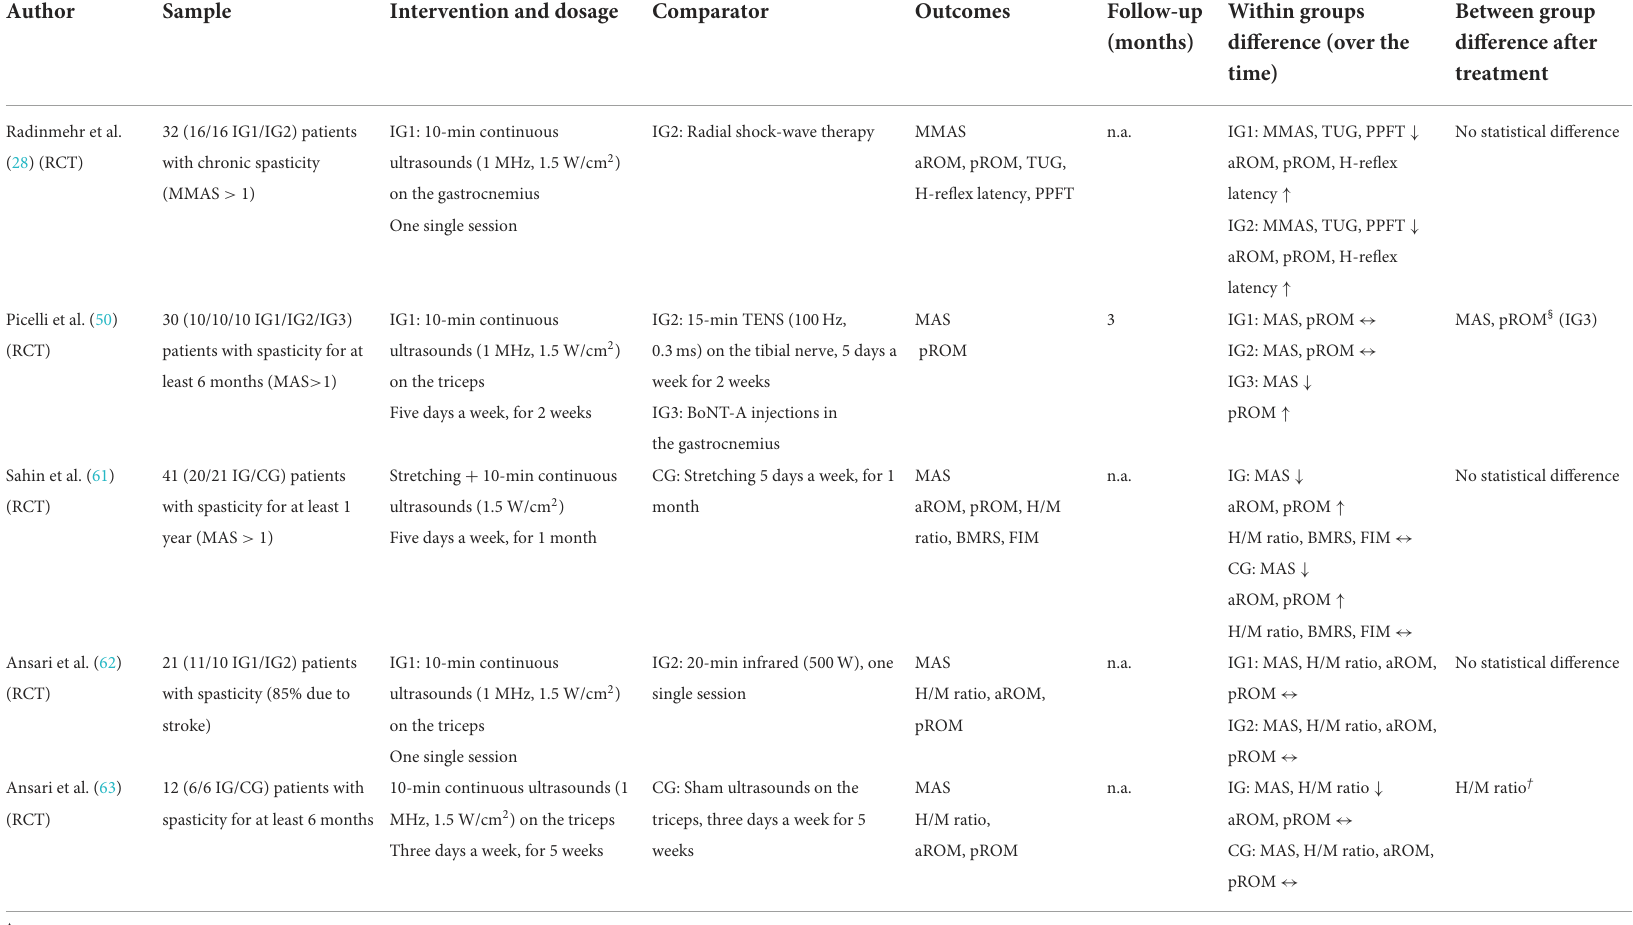
TABLE 7 Characteristics of studies using ultrasounds for the treatment of triceps spasticity after